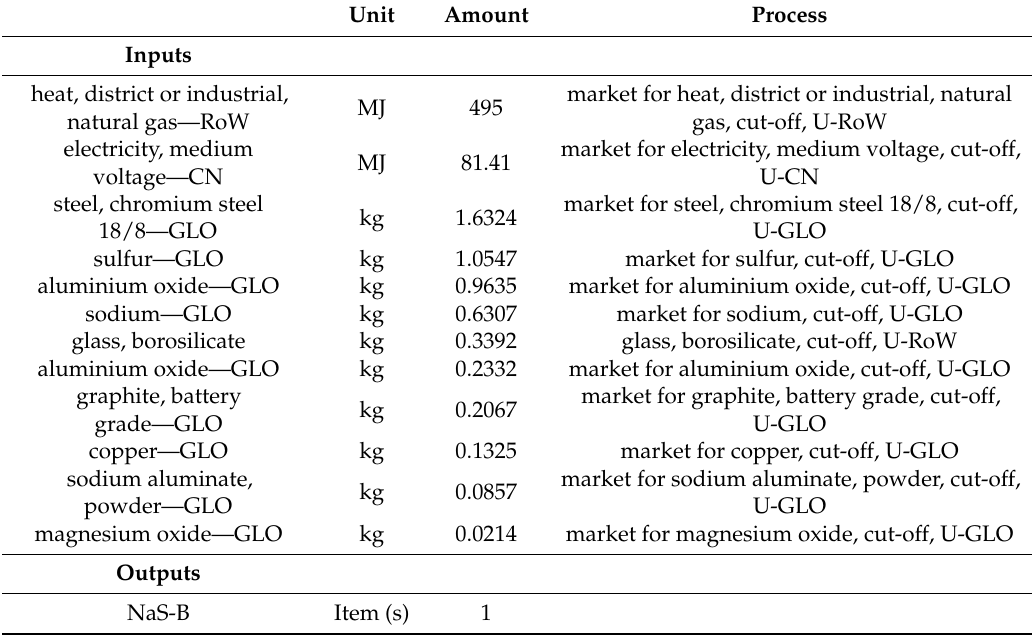
Table A27. Manufacturing, NaS-B.